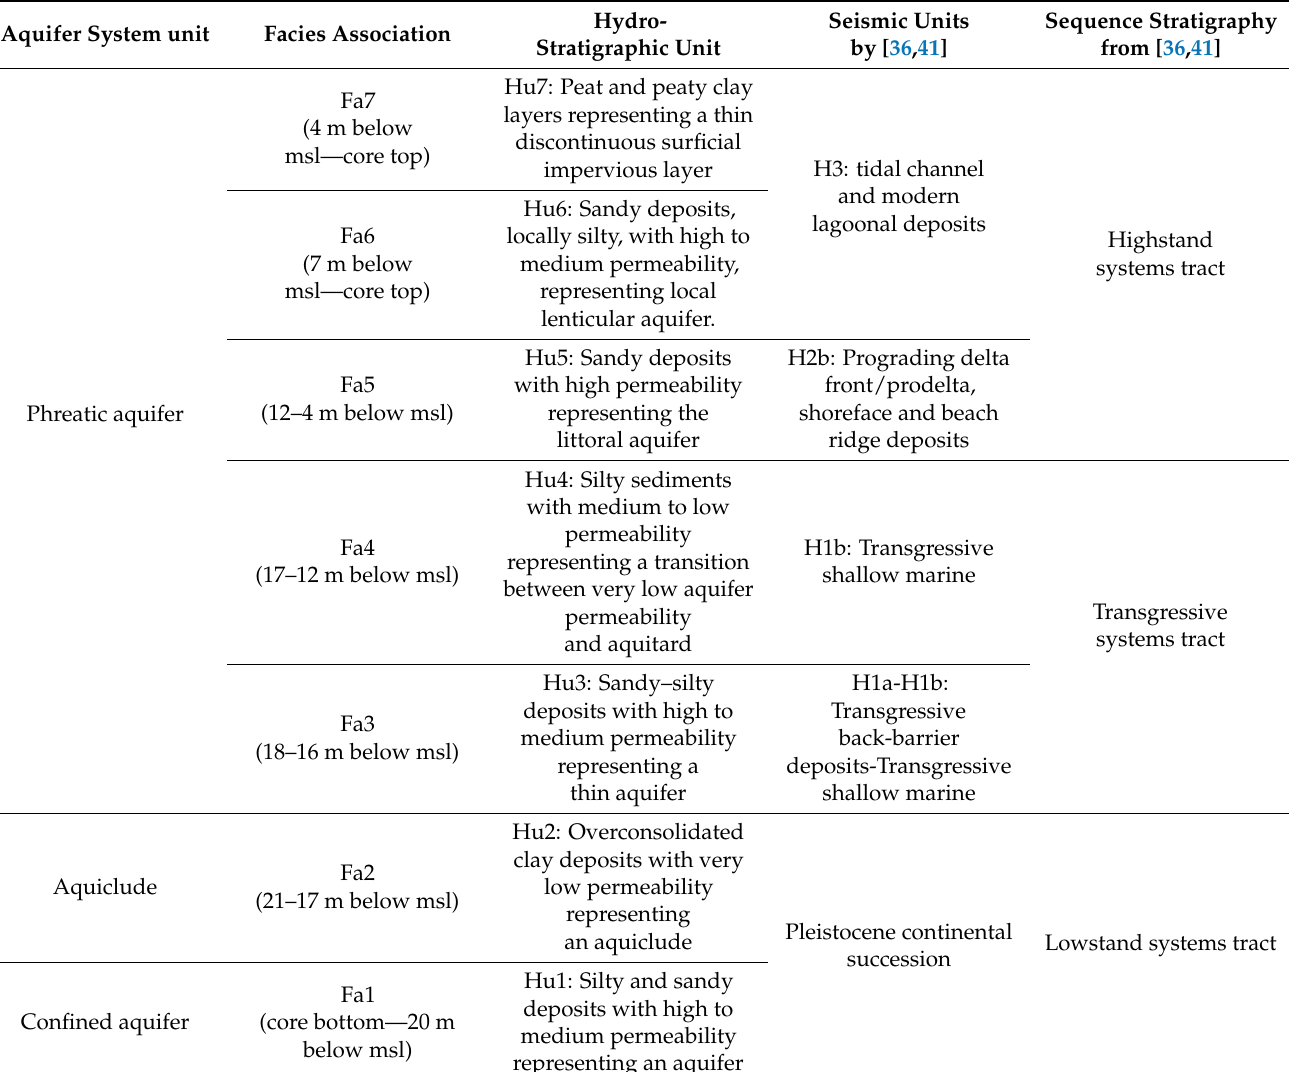
Table 1. Correlation between the facies association and the hydrostratigraphic units as defined in this study and the seismic and sequence stratigraphic units defined in